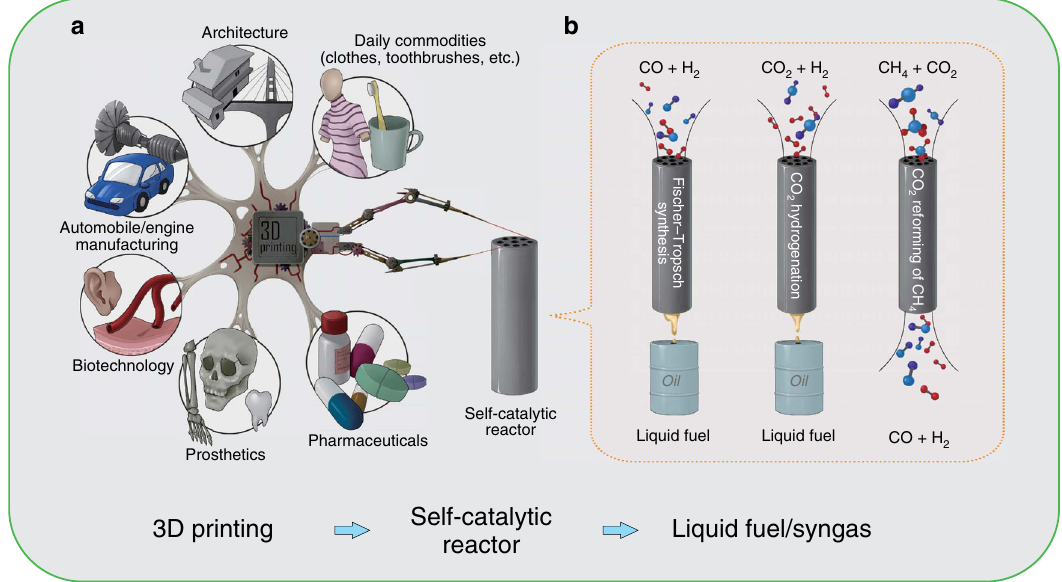
Fig. 1 3D printing for self-catalytic reactor (SCR) and other typical applications. a 3D printing for SCR and other typical applications. b The SCR for Fischer – Tropsch (FT) synthesis, CO 2 hydrogenation, and CO 2 reforming of CH 4